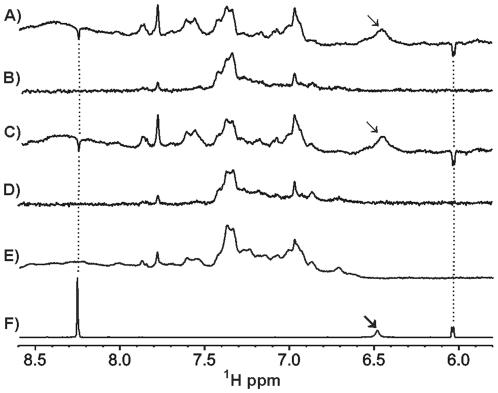
Sections of ligand detected 1D 1H-NMR spectra from the analysis of weak molecular interactions between YtvA and GTP.WaterLOGSY (A) and STD-Watergate (B) of 20 µM dark state YtvA mixed with 200 µM GTP. WaterLOGSY (C) and STD-Watergate (D) of 20 µM lit state YtvA mixed with 200 µM GTP. Watergate of (E) 20 µM dark state YtvA and (F) 200 µM GTP. Signals belonging to GTP are connected by dotted lines. Exchangeable ligand protons are marked by arrows.